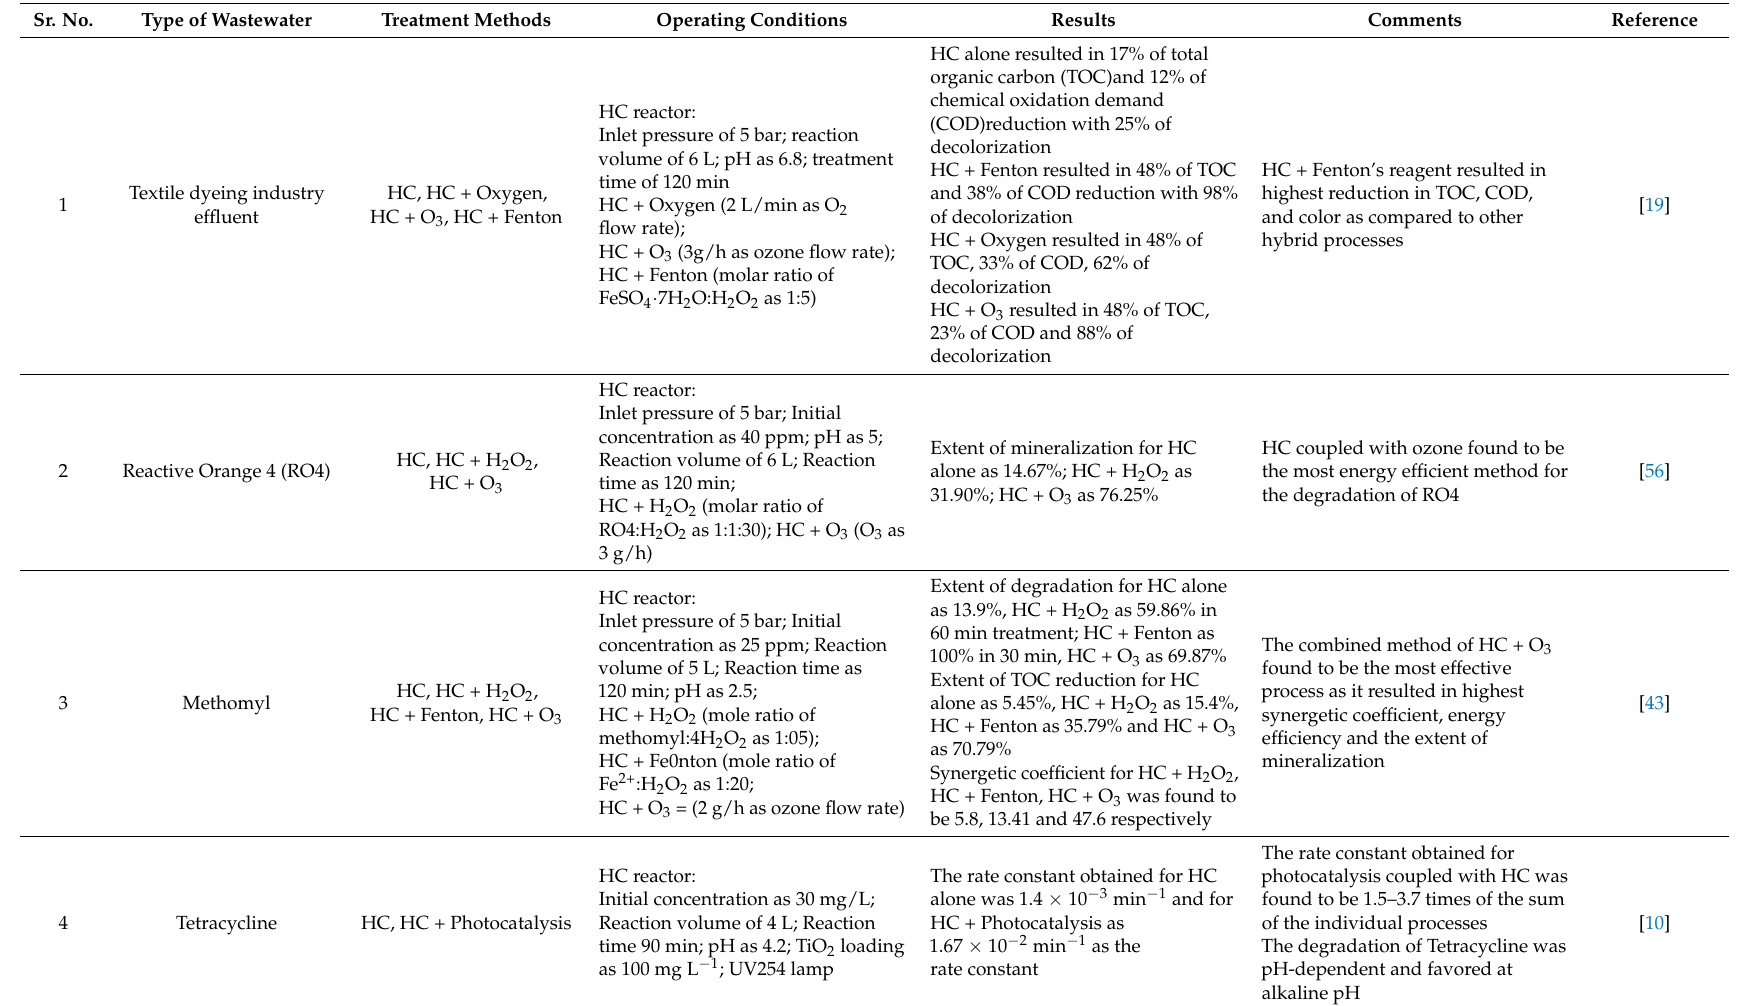
Table 1. Overview of work done on the treatment of wastewater using HC combined with advanced oxidation processes (AOPs). Sr.